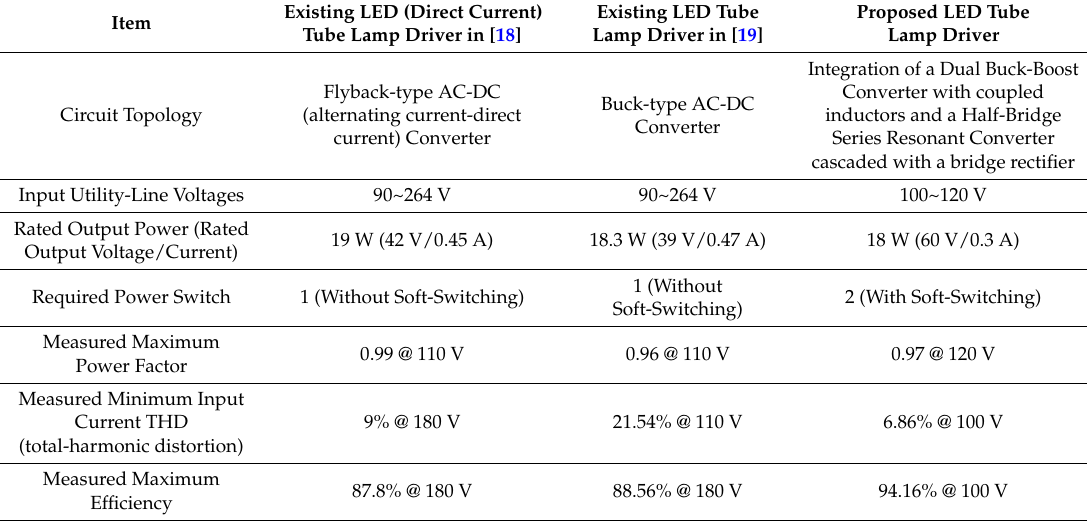
Table 3. Comparisons between the existing t8-type led tube lamp drivers and the proposed